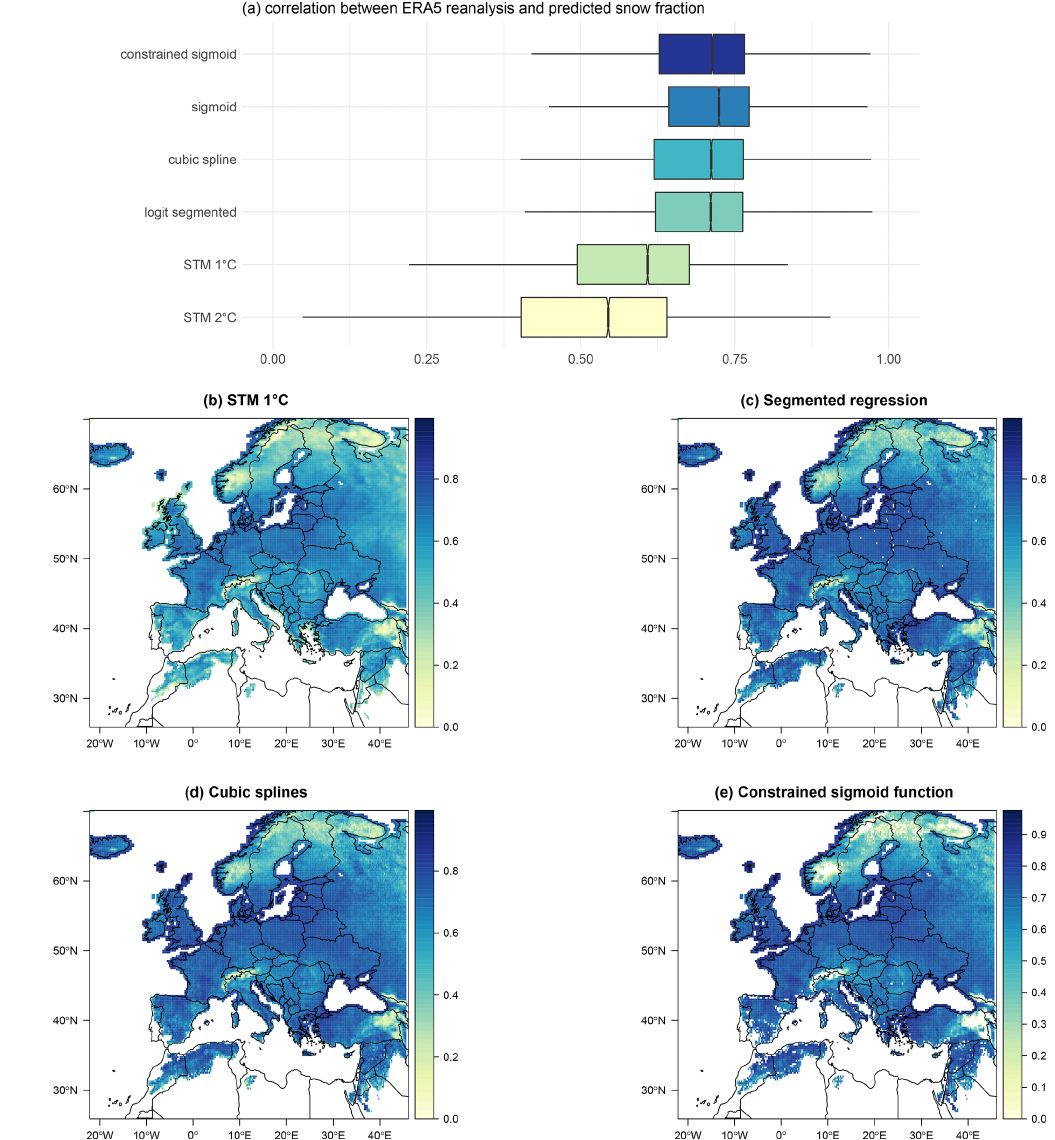
Figure 4. Box plots of correlation coefficients between the ERA5 reanalysis and predicted snow fraction, using the five selected methods, for all grid points with at least 30 snowfall events (a) . Mapped values of the snowfall correlation coefficient for the STM (b) , segmented logit-linear regression (c) , cubic spline regression (d) , and constrained sigmoid fit (e) . White areas over Scandinavia, the Alps, Türkiye and isolated points in Spain, southern France, and Italy shown in panel (e) are due to the non-convergence of the constrained sigmoid